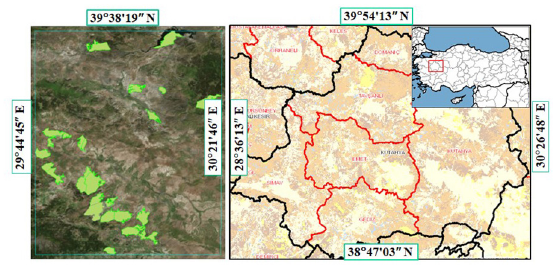
Figure 2. Satellite imagery of forest parcels (left) and geographical boundaries of the Kütahya regional directorate of forestry and forestry operation directorates in Itrf datum (right)